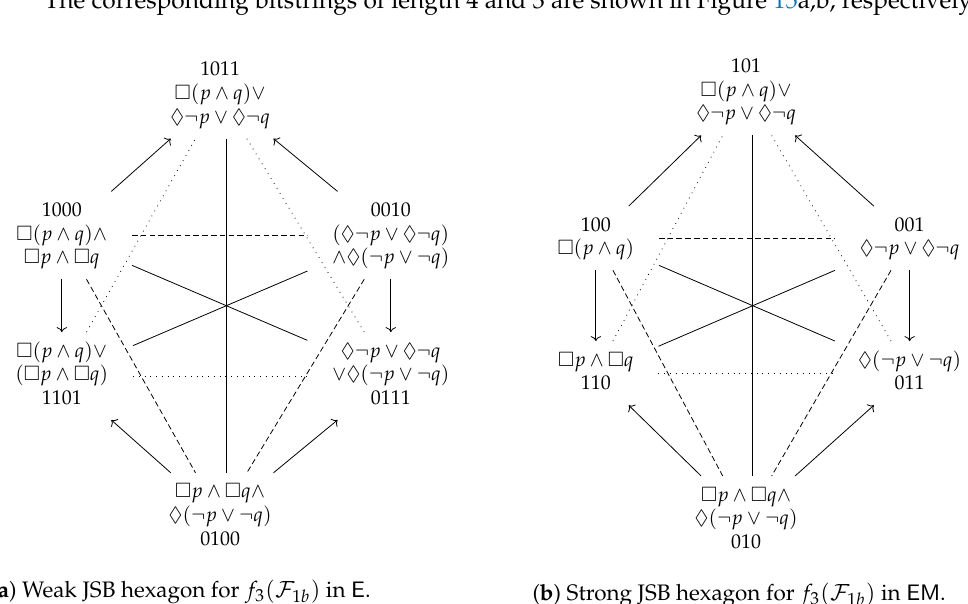
Figure 15. Aristotelian diagrams for f 3 ( F 1 b ) = { (cid:3) ( p ∧ q ) ∧ (cid:3) p ∧ (cid:3) q , (cid:3) p ∧ (cid:3) q ∧ ♦ ( ¬ p ∨ ¬ q ) , ( ♦ ¬ p ∨ ♦ ¬ q ) ∧ ♦ ( ¬ p ∨ ¬ q ) , (cid:3) ( p ∧ q ) ∨ ( (cid:3) p ∧ (cid:3) q ) , (cid:3) ( p ∧ q ) ∨ ♦ ¬ p ∨ ♦ ¬ q , ♦ ¬ p ∨ ♦ ¬ q ∨ ♦ ( ¬ p ∨ ¬ q ) } in two non-normal modal